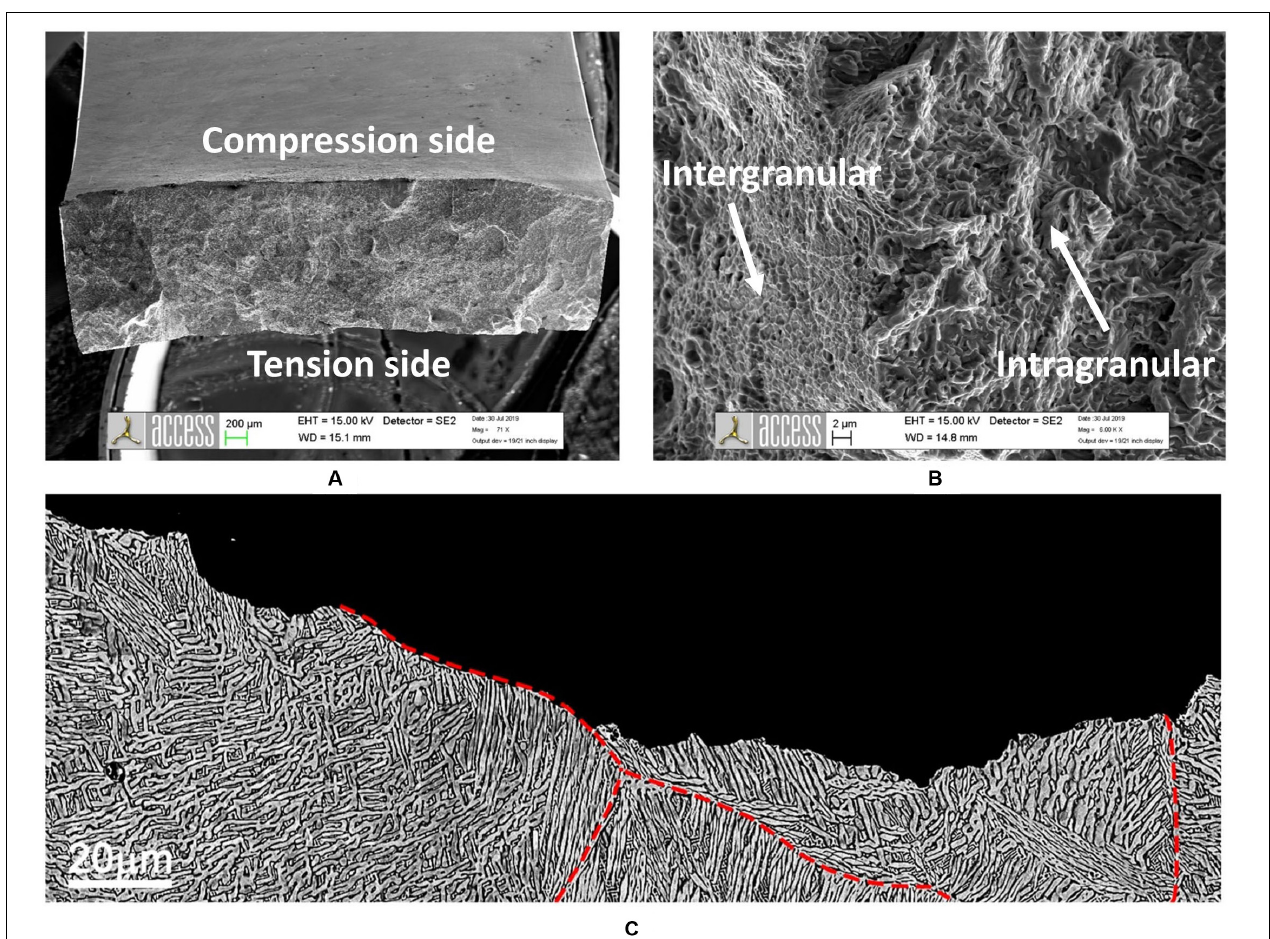
FIGURE 9 | Overview SEM-SE image of an as-cast Mo 2 specimen fractured surface in (A), in (B) a high magnification fracture surface image with (left) an intergranular fracture region and (right) an intragranular fracture region. (C) shows a perpendicular metallographic section plane of the fracture surface with (red strokes) outlined grain